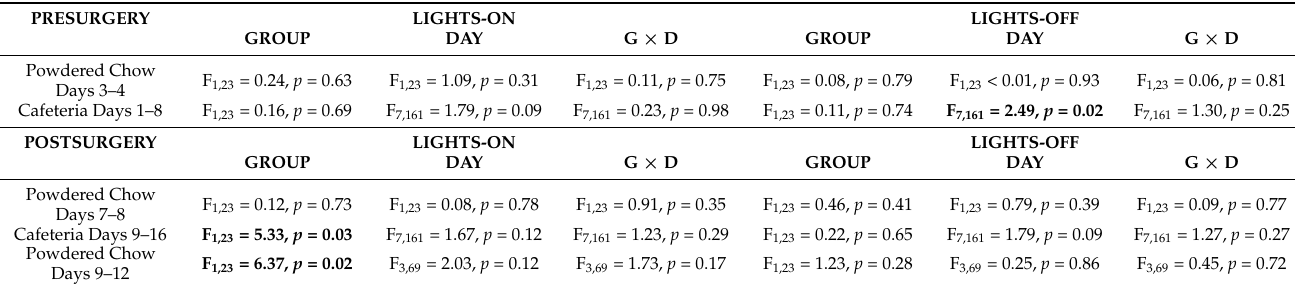
Table 20. Two-way ANOVAs Comparing Intermeal Interval for Lights-On and Lights-Off Meals between Groups for Each Diet Condition.